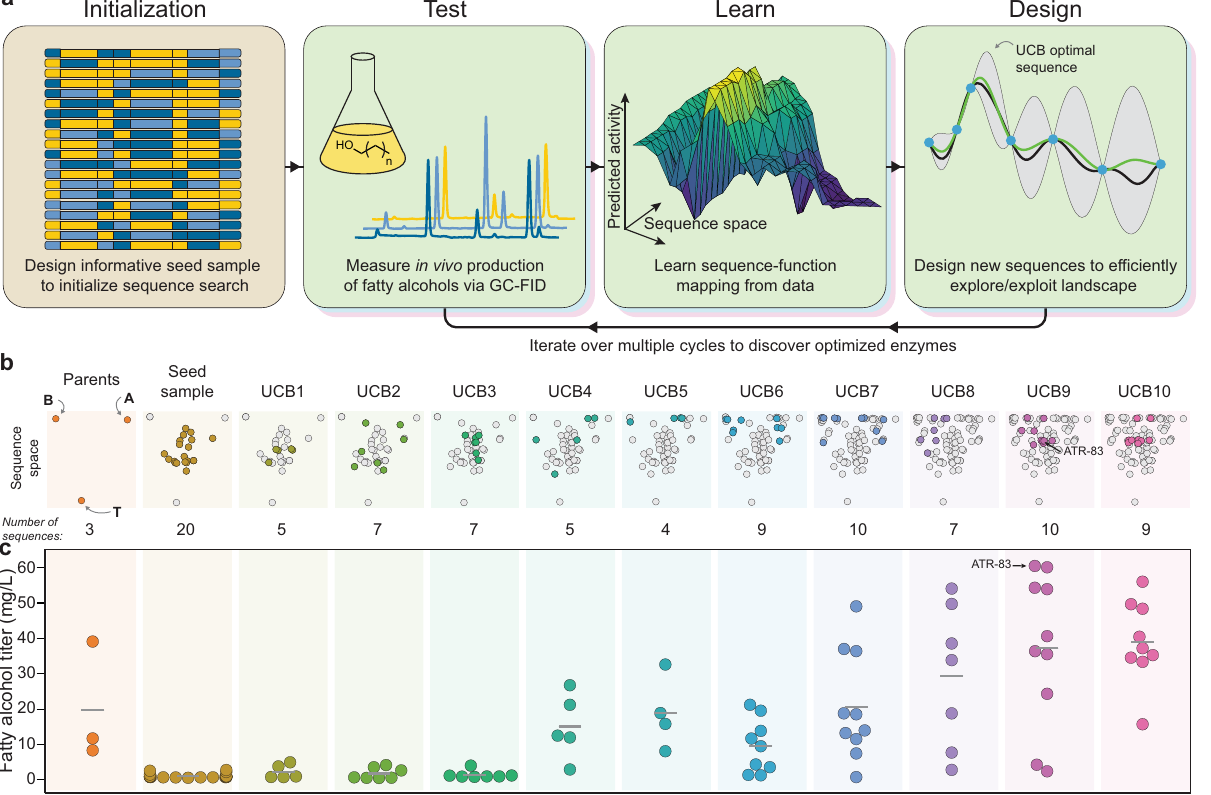
Fig. 2 ML-accelerated protein sequence optimization. a An overview of our sequence space search strategy. We fi rst initialize the search by designing a diverse set of sequences that broadly sample the landscape. We then iterate through multiple design-test-learn cycles to ef fi ciently understand and optimize in vivo fatty alcohol production. b Sequence space visualization over ten rounds of UCB optimization (each round is shown as a different color). The three parent enzymes are found at the vertices of this chimeric sequence space and all chimeras fall within the parents ’ envelope. The UCB optimization started by broadly sampling the landscape, but quickly converged on highly active regions. c The in vivo fatty alcohol titers over the course of the sequence optimization. Each point depicts an individual sequence ’ s mean fatty alcohol production in the sequence optimization phase and the horizontal gray bars represent the average titer during that round of sequence optimization. The mean, standard deviation and number of replicates, where n is equal to the number of cultures analyzed (each one from an individual colony), are shown in Supplementary Table 5. Source data underlying Fig. 2c are provided as a Source Data fi